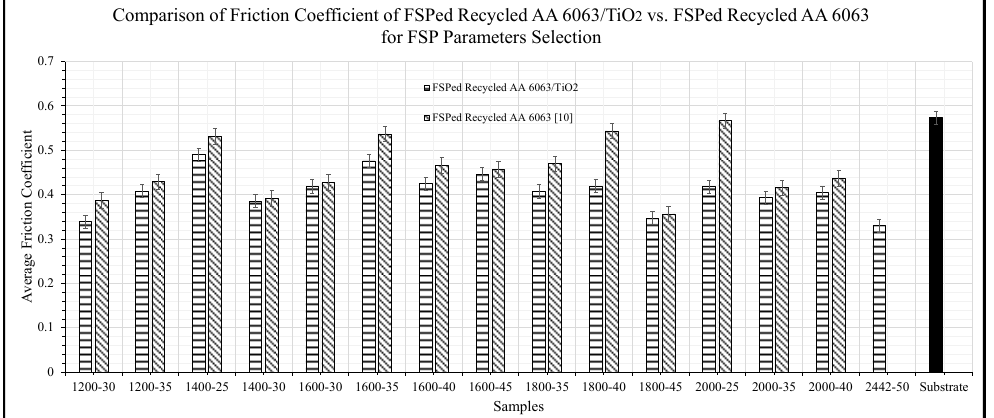
Figure 21. The comparison of the average friction coefficient of substrate material, FSPed recycled AA 6063 and FSPed recycled AA 6063/TiO 2 subjected to a nominal contact pressure of 0.24 MPa at a sliding speed of 2.88 m/s under starved lubrication conditions.